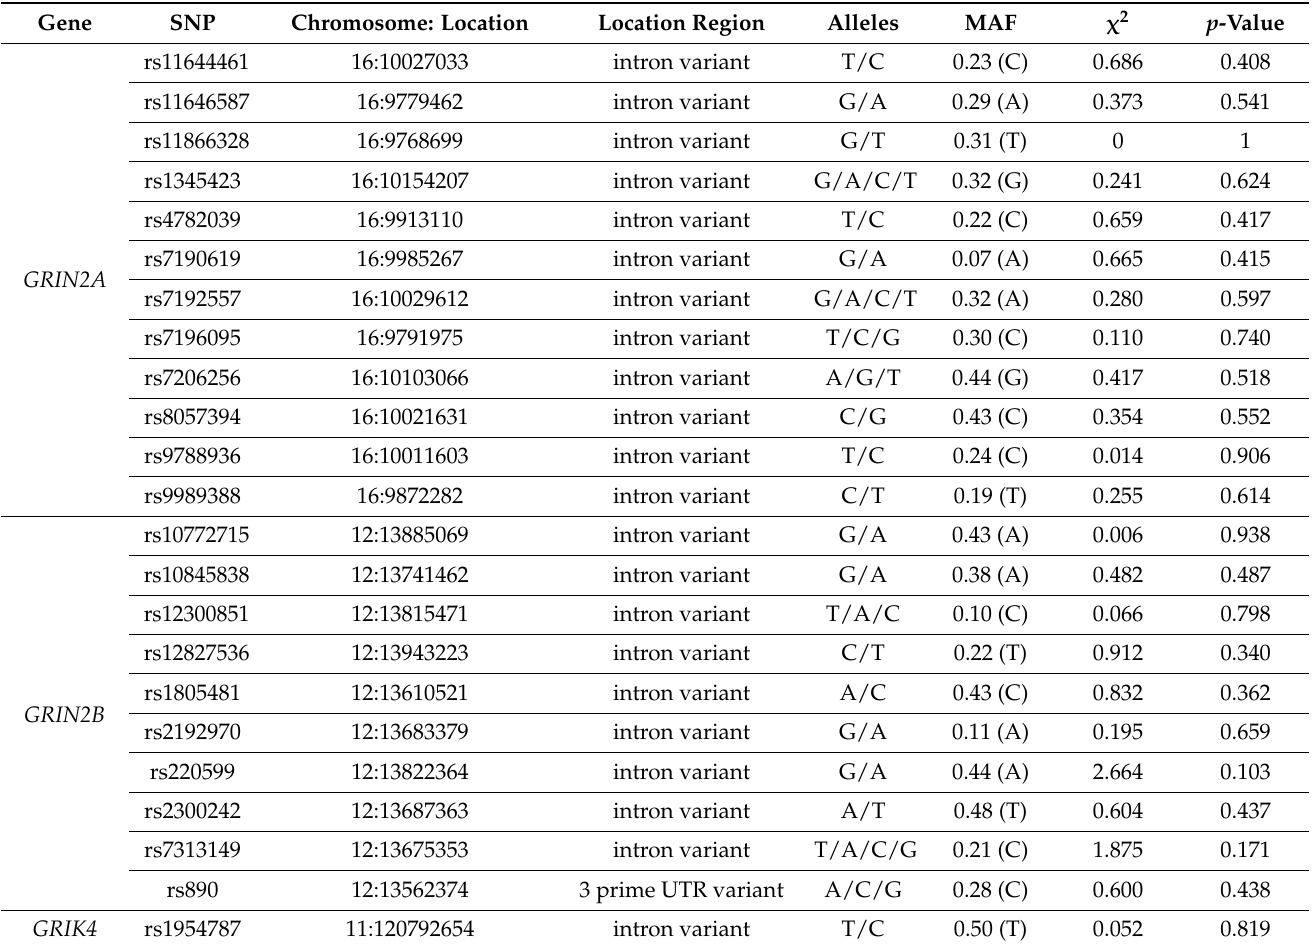
Table 1. The basic information of analyzed polymorphic